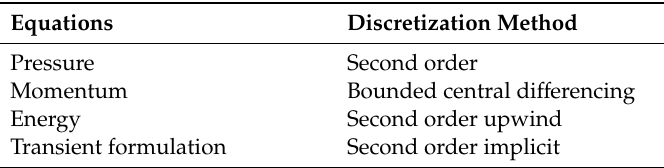
Table 1. Discretization schemes of governing